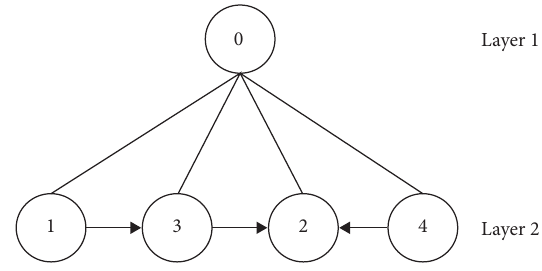
Figure 2: The directed graph of the gearbox